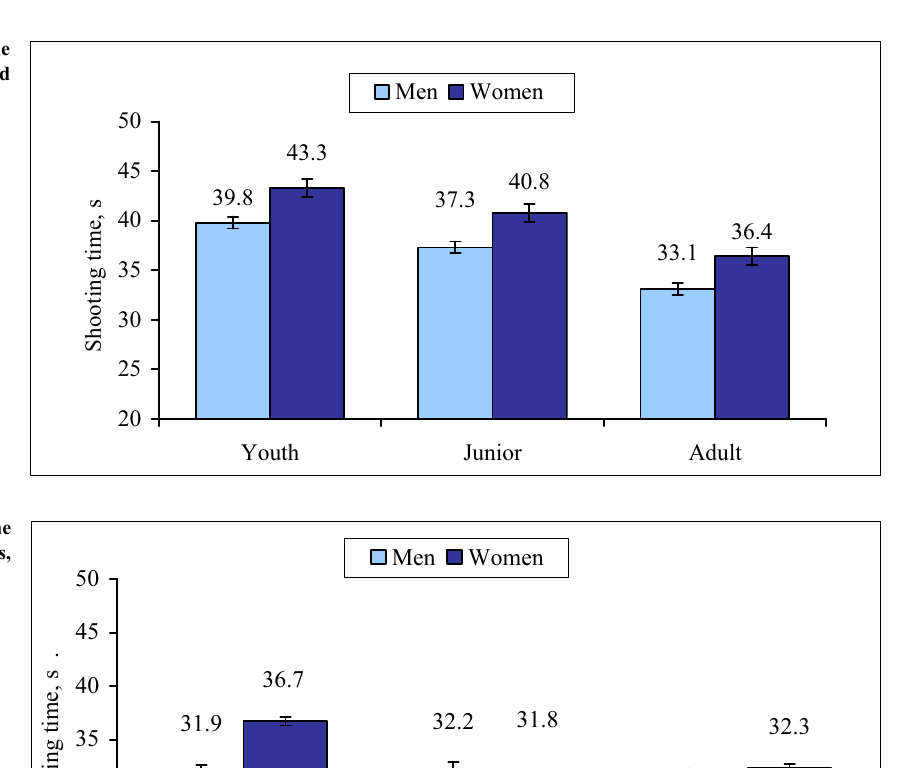
Figure 2. Shooting accuracy of various age group men biathletes, in prone and stand Figure 3. Average shooting time positions (X ± Sx) of various age groups, men and women (X ± Sx)